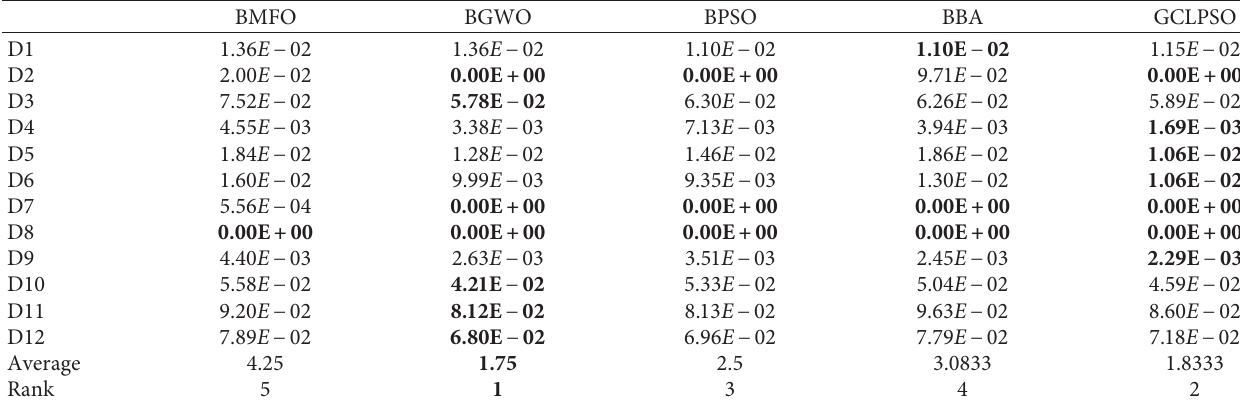
Table 8: Average error rate of the GCLPSO and other feature selection algorithms on datasets.